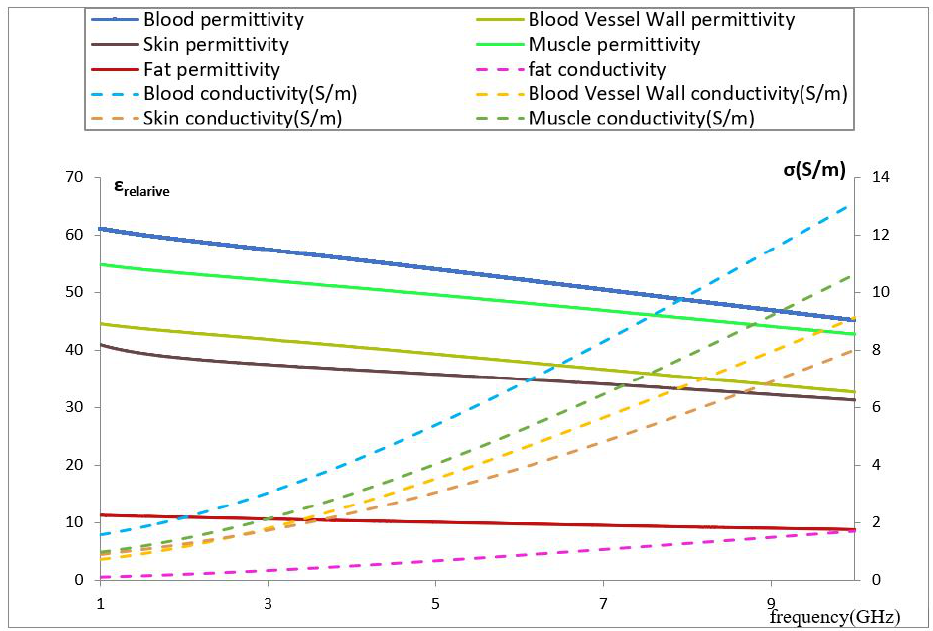
Figure 1. Permittivity and conductivity vs. frequency for different biological tissues